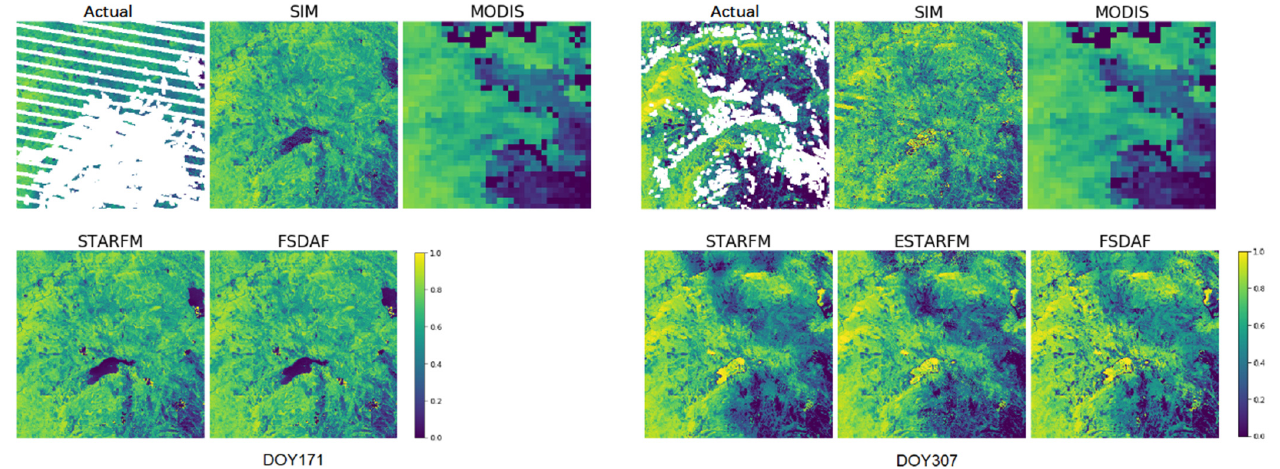
Figure 11. Actual and predicted NDVI images using different methods at the NRM area from DOY 171 and DOY 307. Table 8. Accuracies of different methods for NDVI prediction at the NRM area from DOY 171 and DOY 307. Methods DOY 171 DOY 307